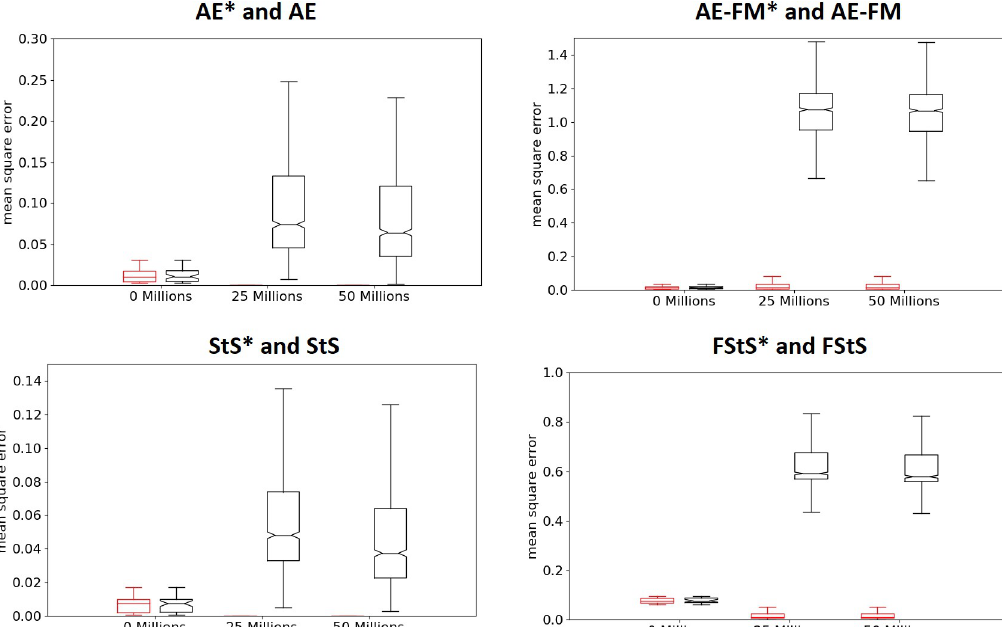
Fig 4. Mean-squared error produced by the features-extracting networks before the training of the control network (0 steps) and during the training of the control network (after 25 and 50 � 10 6 steps). Results of the experiments performed in the AE, AE-FM, StS, and FStS experimental conditions. The boxplots shown in black and red shows the data of the experiments performed in the pre-trained and continuous training modalities, respectively. In the case of AE � and StS � conditions, some of the red boxplots are not visible because the distribution of the offset is close to